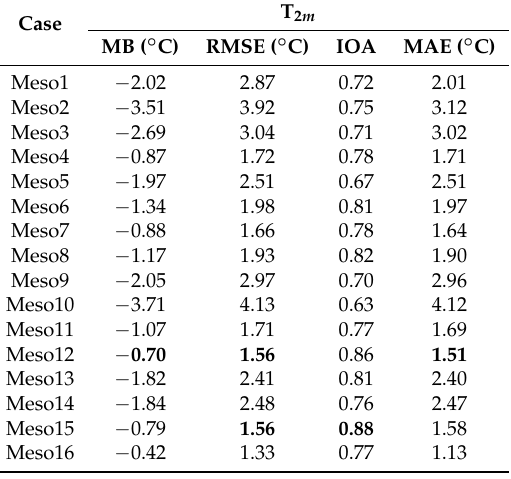
Table A1. Statistical measures for 2-m temperature in mesoscale simulations performed. Bold values represent the best